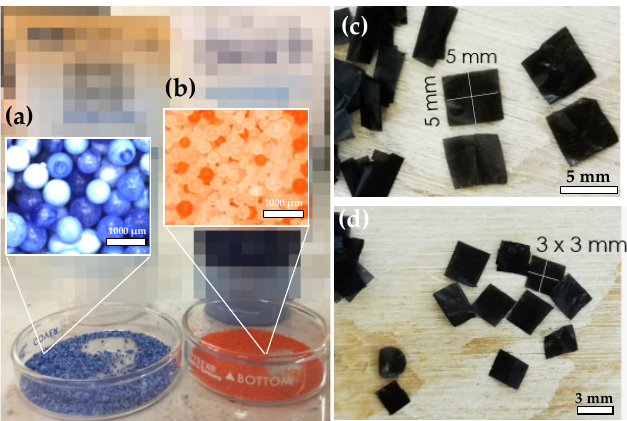
Figure 4. Optical micrographs of: ( a ) HDPE_A; ( b ) HDPE_B; ( c ) LDPE_5 mm × 5 mm; and ( d ) LDPE_3 mm × 3 mm microplastics.